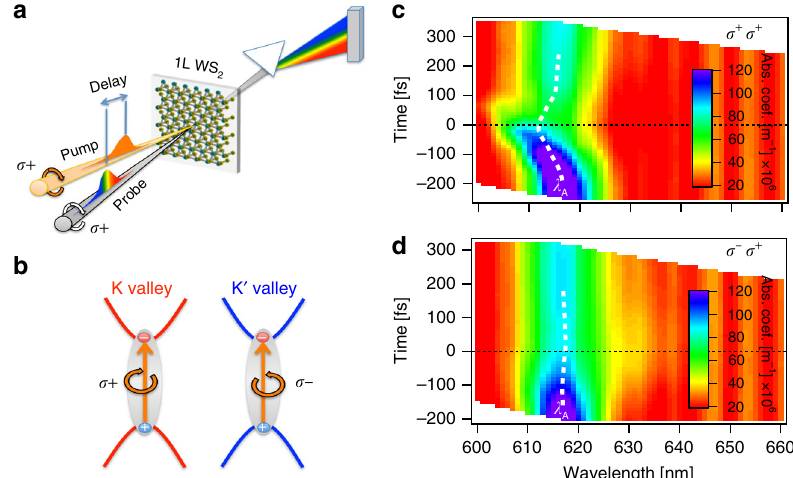
Fig. 1 The valley-selective optical Stark effect in monolayer WS 2 . a Schematic of the valley-resolved transient absorption experiment. b The K - and K ′ - valleys are populated by right-hand ( σ + ) and left-hand ( σ − ) circularly polarized light due to chiral selection rules. c Summary of time-dependent, room temperature, absorption spectra of monolayer 1L WS 2 recorded with a σ + white-light probe upon 610 nm excitation with co- ( σ + σ + ) and d cross-circularly polarized ( σ − σ + ) light. The center wavelength of the A-exciton resonance ( λ A ) is indicated with a dashed white light. Time zero indicates when the pump and probe pulse are temporally